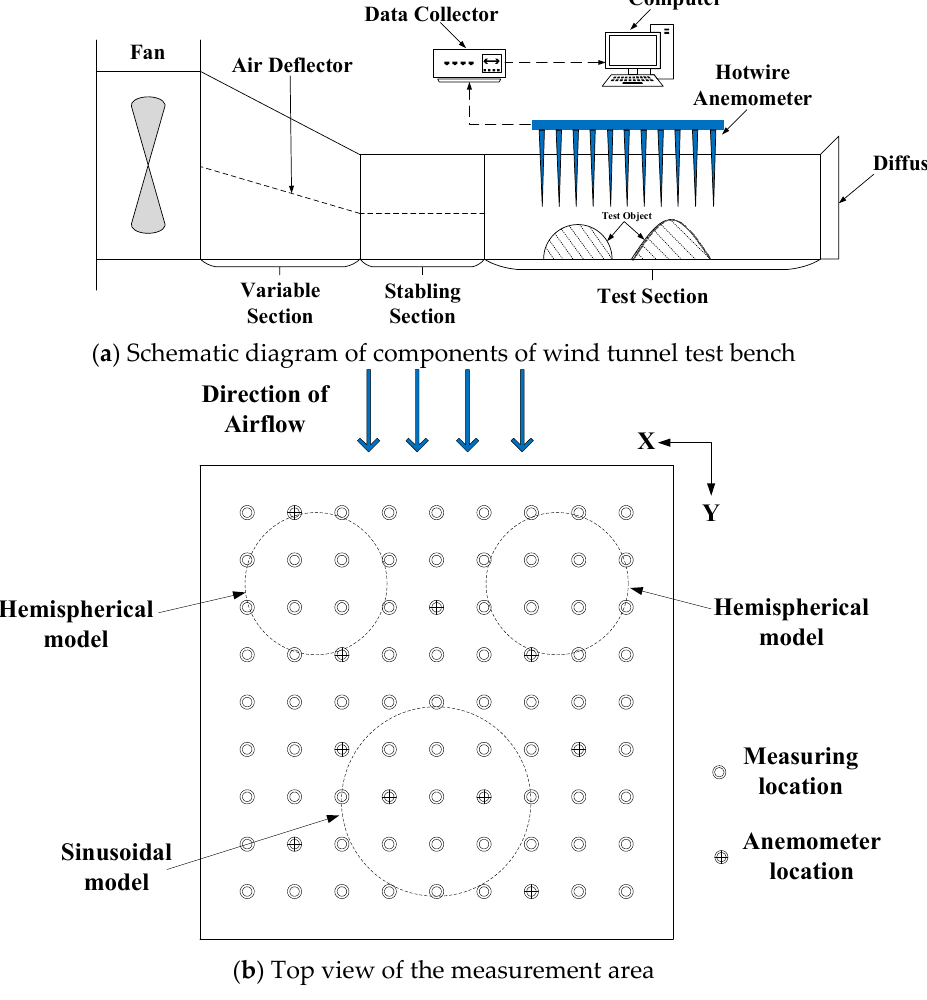
Figure 4. Schematic diagram of wind tunnel test bench and measuring section.